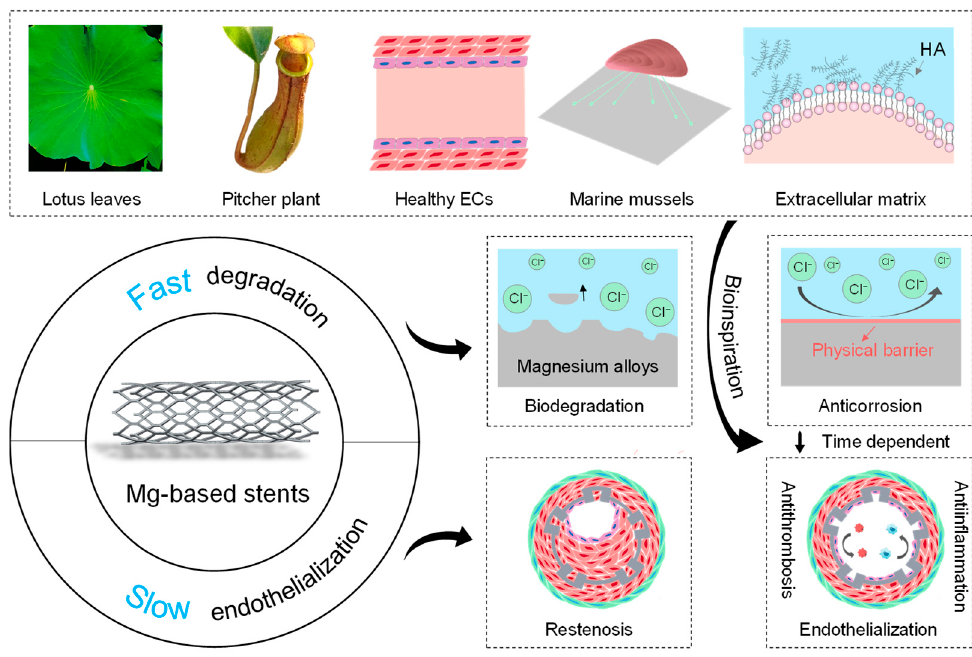
Figure 1. Schematic illustration of bioinspired strategies for Mg-based stents with enhanced corrosion resistance and promoted endothelialization.